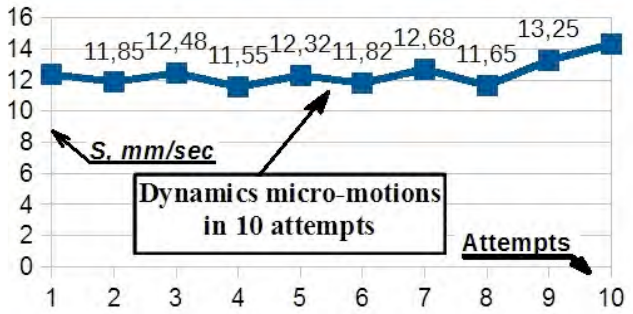
Fig. 3. Dynamic of elite shooters hands’ micro movements in 10 series of exercise Air